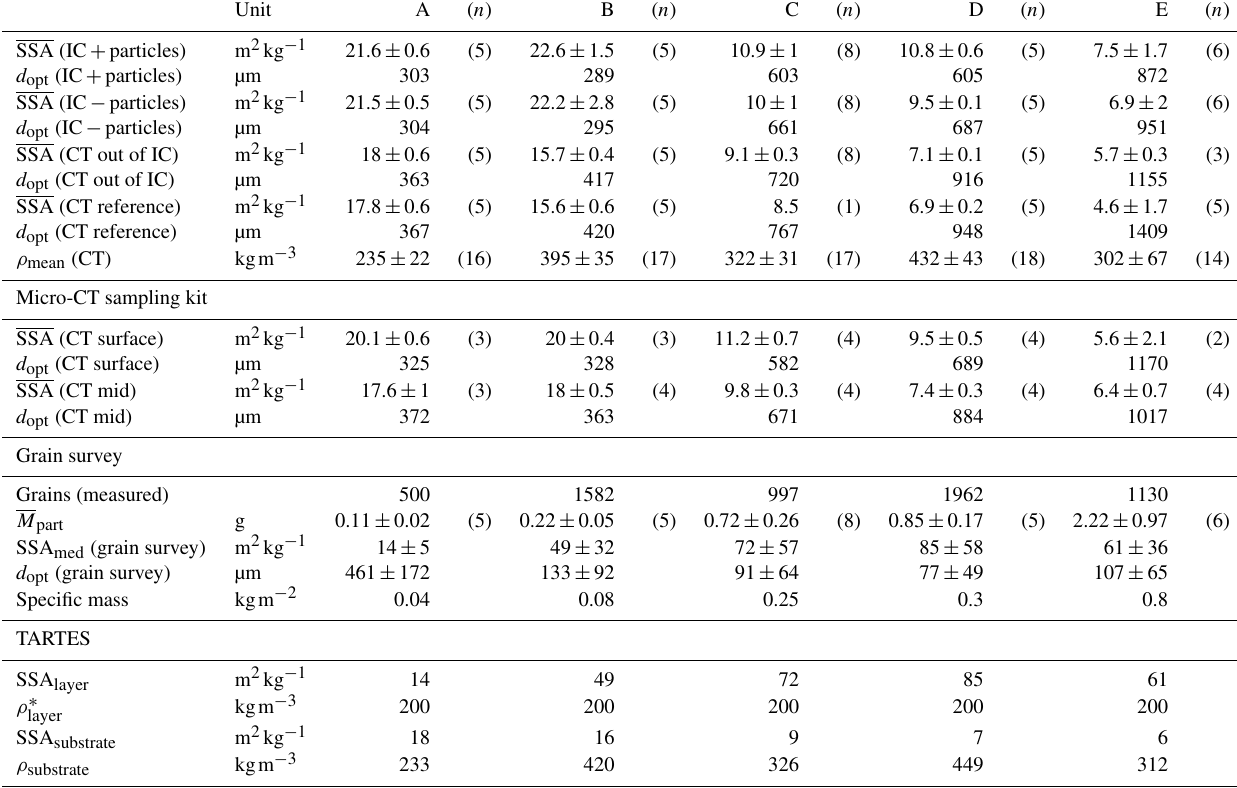
Table 1. Means, standard deviations and the number of measurements ( n ) for all measurements organized following the multi-level sampling strategy. “IC + particles” represents the default sampling procedure suggested by Gallet et al. (2009). The “ ρ ∗ used for the TARTES simulations. For access to the data set, the reader is referred to the Code and data availability